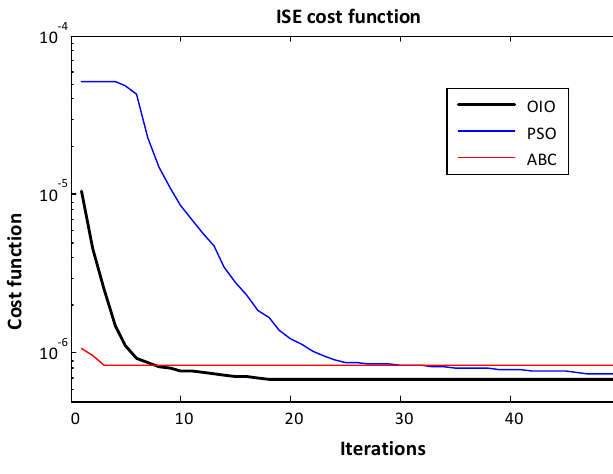
Figure 22. Iteration history for ITSE. 5. Conclusions In this paper, the OIO algorithm was proposed for optimizing controller gains in load frequency controls in electrical power systems. The reason to use the method developed by Kashan is that it reaches the global minimum value faster. The method was compared with PSO and ABC methods which are widely used in literature. The idea behind choosing these methods is that their initial conditions are randomly defined. These three methods were optimized with two different test systems and four different cost functions. According to the results obtained, OIO algorithm converges to the global minimum value with ten iterations in average. The results obtained from these two test systems can be ordered as follows: OIO algorithm has found lowest cost value. OIO algorithm reaches to the global minimum value in short time. OIO can converge with less number of population. OIO algorithm has the total lowest optimization time. As the authors conclude from the results explained above, they propose OIO algorithm in specifying PID gains online for a two ‐ area power systems in laboratory applications for future studies. Author Contributions: Mahmut Temel ÖZDEM İ R proposed the novel idea behind this work, designed the algorithm framework, and prepared manuscript; Dursun ÖZTÜRK performed the simulations for the two area